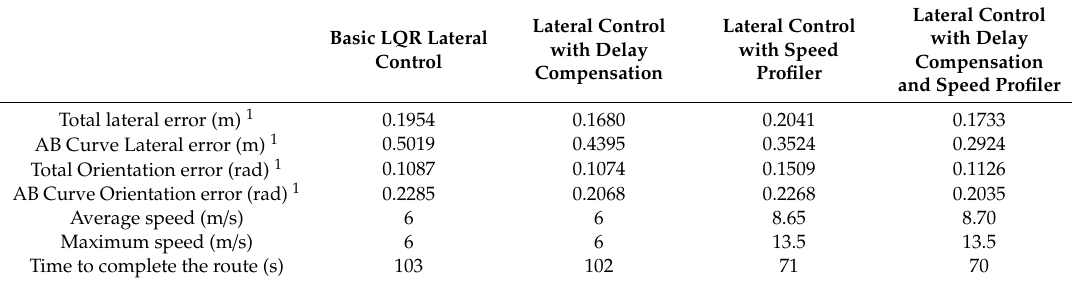
Figure 10. Test bench in the CARLA Simulator: ( a ) 610-meter route in Town_03 used for the tests (AB segment is used to compare results in curves), ( b ) view of the route in Rviz Robot Operating System (ROS) visualizer, with the input waypoints shown as red points, ( c ) a closer view of vehicle model making the first turn in CARLA, ( d ) Rviz view of the same turn, with trajectory and reference pose markers for visualization. Table 2. Ablation tests